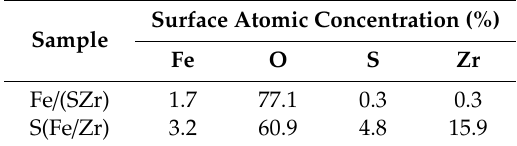
Table 2. Surface atomic concentration of various catalysts by XPS